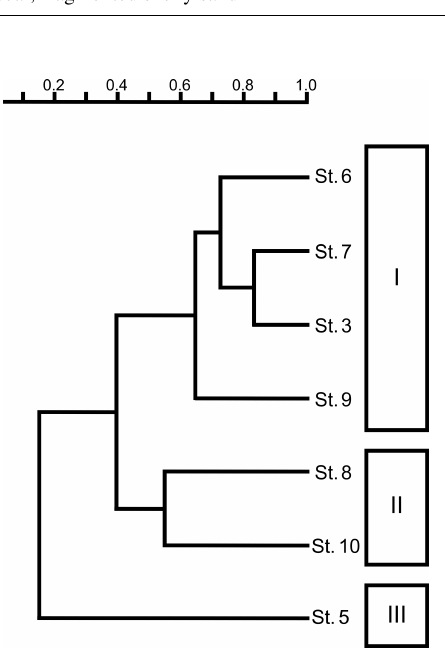
Figure 2. Dendrogram of Q-mode cluster analysis showing the three different biofacies (I, II, and